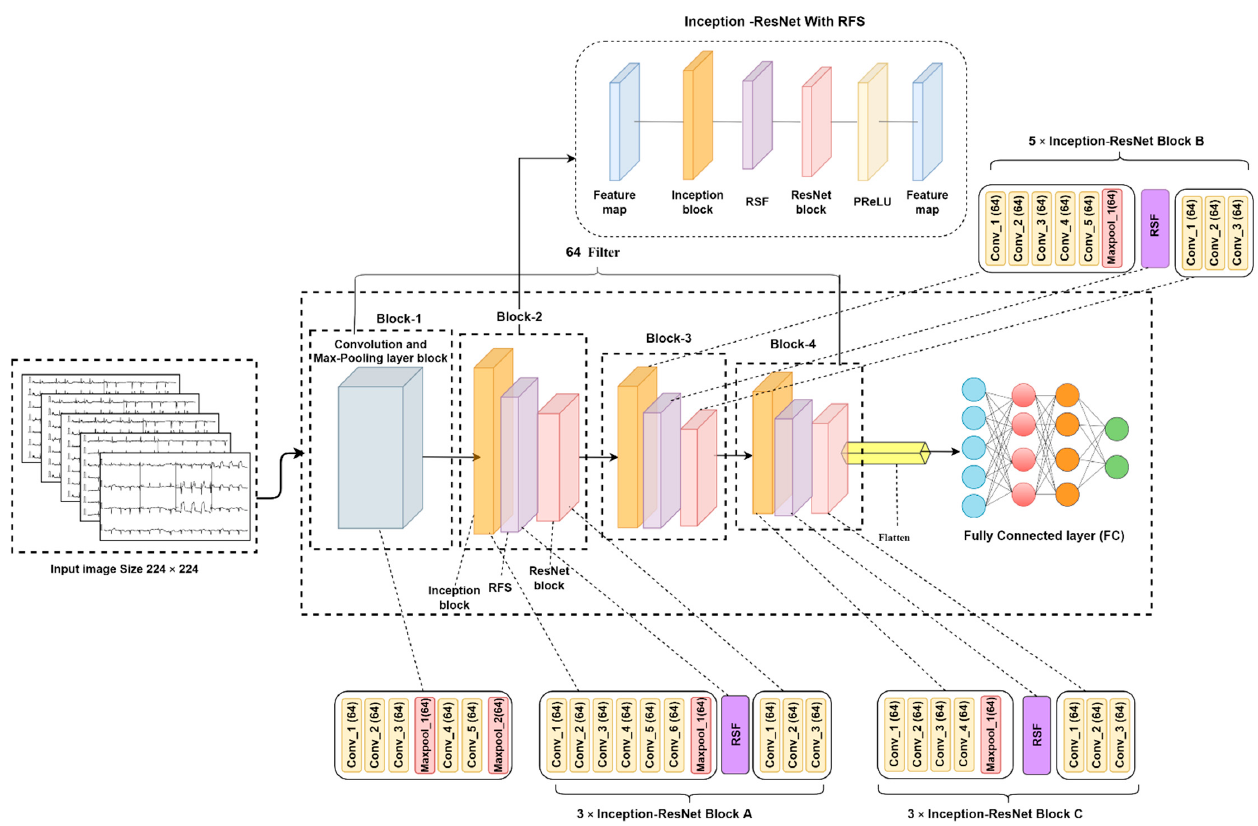
Figure 11. Proposed model architecture.